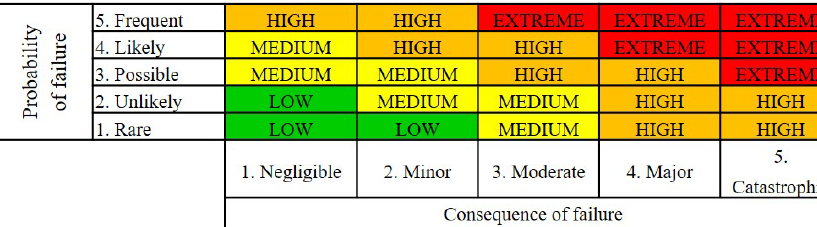
Figure 15. A typical risk matrix diagram.